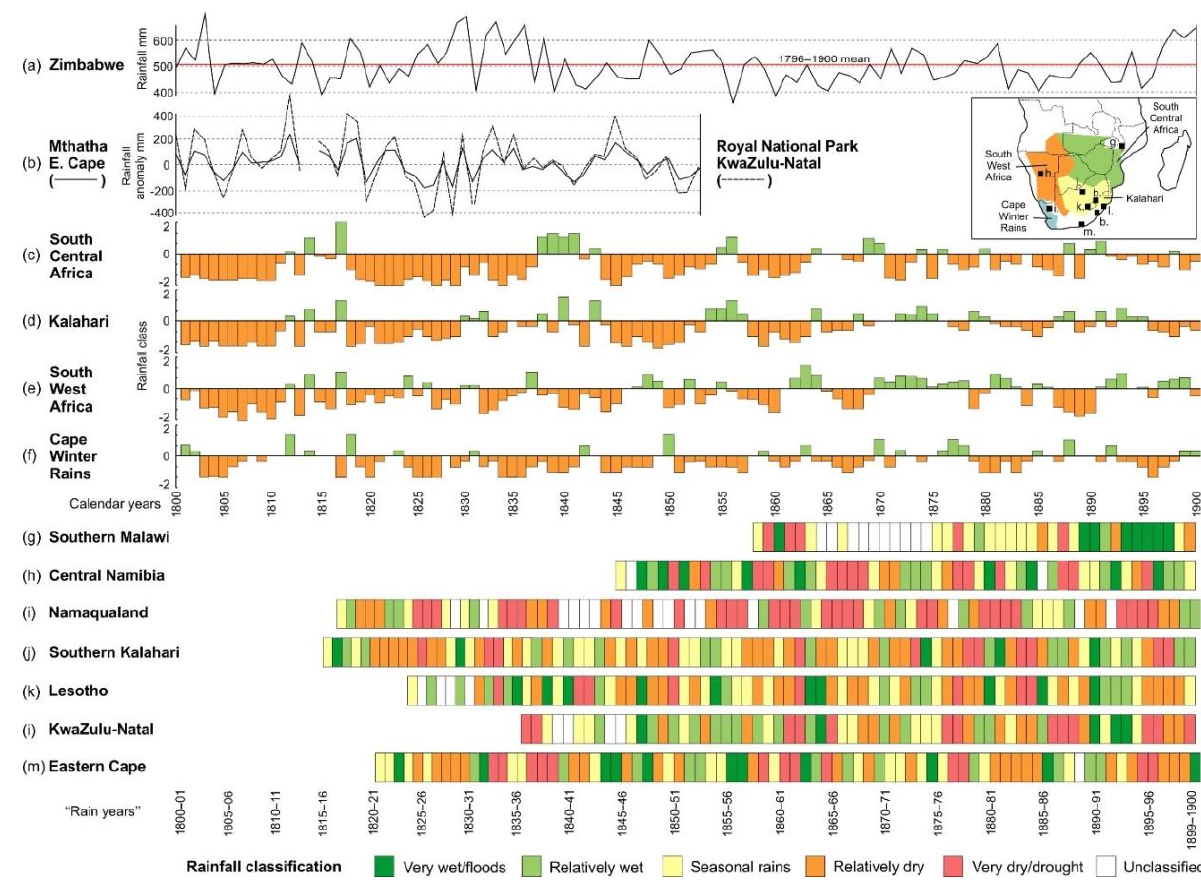
Figure 11. Long-term fluctuations in a range of documentary-based drought series for the southern African summer and winter rainfall zones for the 19th century (see Sect. 4.1.3): (a) tree ring series for Zimbabwe (Therrell et al., 2006); (b) series derived from ships’ logbooks for Mthatha, eastern Cape, and Royal National Park, KwaZulu-Natal (anomaly relative to 1979–2008 mean) (Hannaford et al., 2015); (c– f) documentary- and gauge-data-derived composite series for “South Central Africa” (Zambia, north-east Botswana, Zimbabwe, southern Mozambique), the “Kalahari” (southern Botswana, northern/eastern South Africa), “South West Africa” (south-eastern Angola, Namibia, north-western South Africa), and “Cape Winter Rains” (south-western South Africa) (Nicholson et al., 2012b); (g–m) documentary-derived series for southern Malawi (Nash et al., 2018), central Namibia (Grab and Zumthurm, 2018), Namaqualand (Kelso and Vogel, 2007), southern Kalahari (Nash and Endfield, 2002a, 2008), Lesotho (Nash and Grab, 2010), KwaZulu-Natal (Nash et al., 2016b) and eastern Cape (Vogel, 1989). Inset map (top right) shows areas covered by composites (c–f) and the approximate locations of other